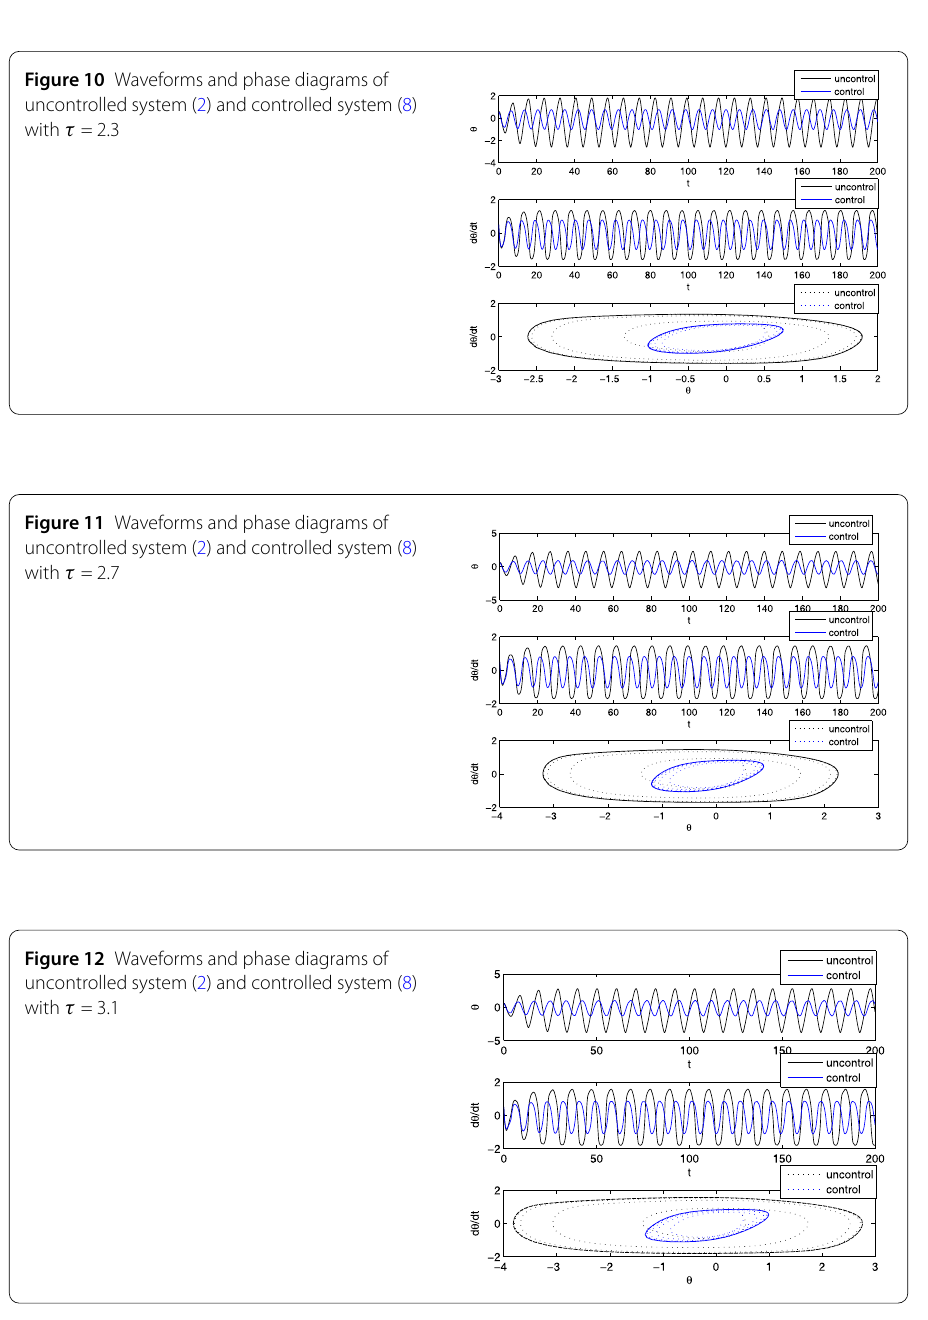
Figure 10 Waveforms and phase diagrams of uncontrolled system (2) and controlled system (8) with τ = 2.3